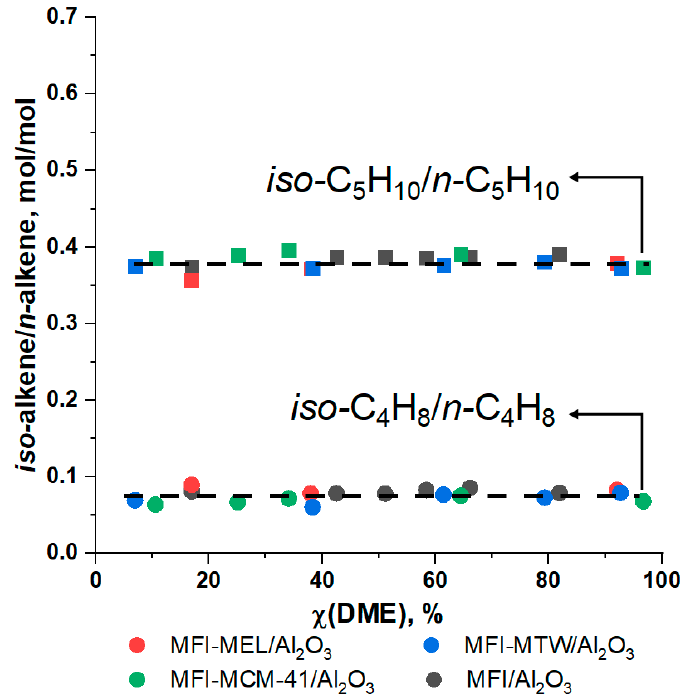
Figure 7. Iso ‐ /n ‐ olefins mole ratio as a function of DME conversion for MF ‐ MEL/Al 2 O 3 , MFI ‐ Figure 7. Iso-/n-olefins mole ratio as a function of DME conversion for MF-MEL/Al 2 O 3 , MFI- MTW/Al 2 O 3 , MFI ‐ MCM ‐ 41/Al 2 O 3 , MFI/Al 2 O 3 catalysts. p = 1 atm, T = 340 °C. MTW/Al 2 O 3 , MFI-MCM-41/Al 2 O 3 , MFI/Al 2 O 3 catalysts. p = 1 atm, T = 340 ◦